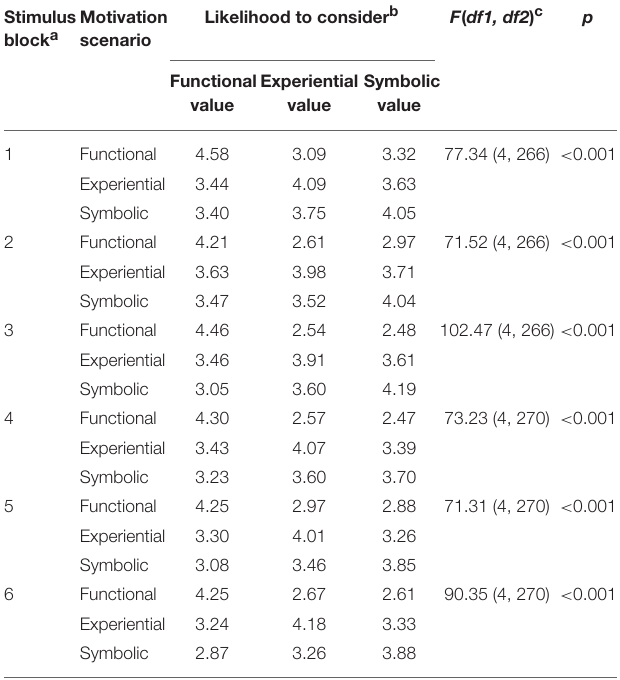
TABLE 1 | Results from the behavioral pretest of the stimuli.